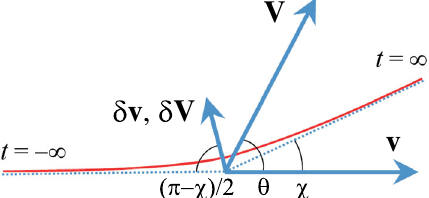
FIG. 5. Sketch illustrating pair collisions in 2D systems. Shown are the variations of the center-of-mass velocity V and the relative velocity v as well as the scattering angle χ , plotted in polar